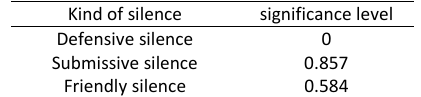
Table 6. Testing of Significance of Types of Silence in Tehran Municipality